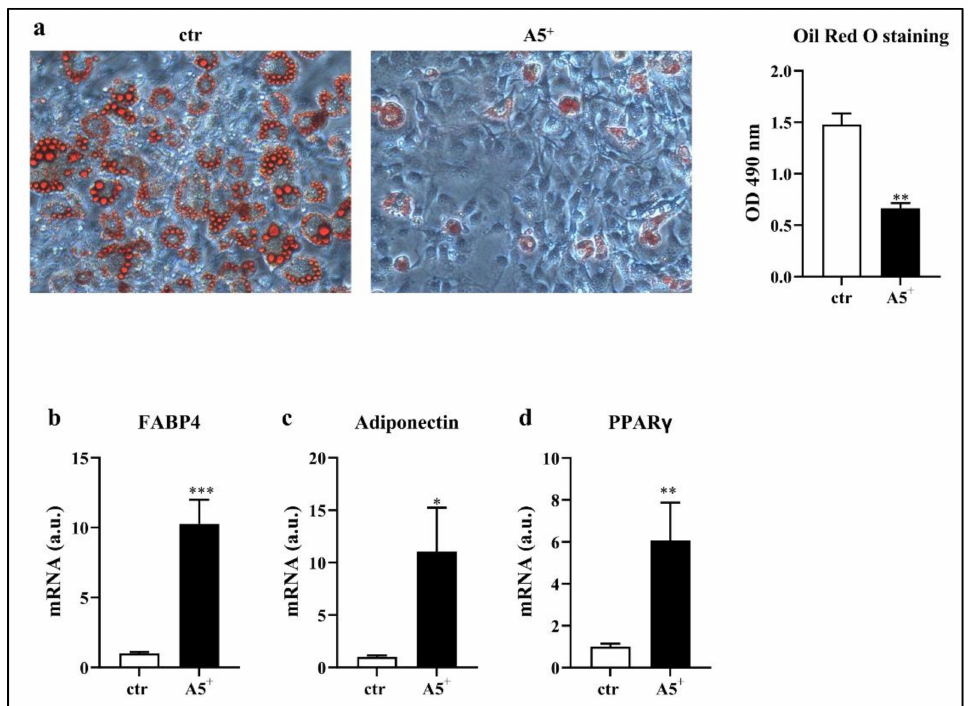
Figure 1. Oil Red O staining in 3T3-L1 adipocytes. Cells were seeded at a density of 1 × 10 5 cells/well in a 6-well plate and differentiated with or without A5 + . ( a ) Cells were stained with Oil Red O and lipid droplets were visualized in optical microscopy (20 × magnification) and quantified by measuring absorbance. ( b – d ) Bar graphs illustrating the most relevant adipogenesis-related genes modulated by A5 + . Results are expressed as the mean ± SEM. * p < 0.05, ** p < 0,005, *** p < 0.001. Graphs illustrate three different experiments conducted separately. FAB4: Fatty acid-binding protein 4; PPAR γ (peroxisome proliferator-activated receptor